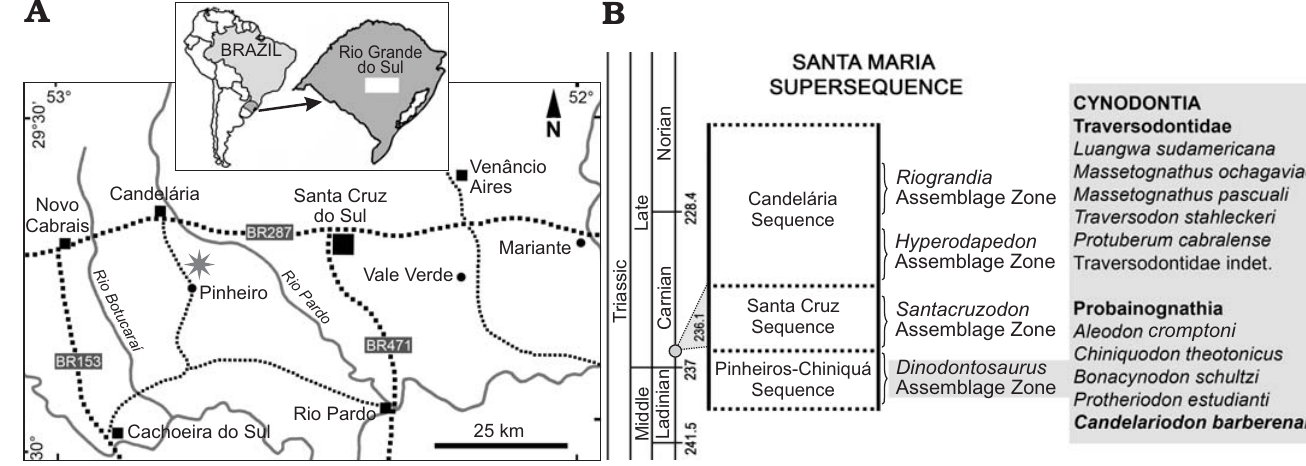
Fig. 1. Geographic ( A , star indicates the type locality) and biostratigraphic ( B ) location of Candelariodon barberenai . The biostratigraphy follows Horn et al. (2014) and the dating (grey circle in B) corresponds to Philipp et al.